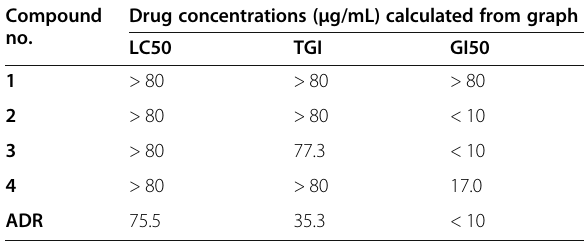
Table 4 Parameters calculated from graph (Fig. 3) HOP62 cell line Compound no.